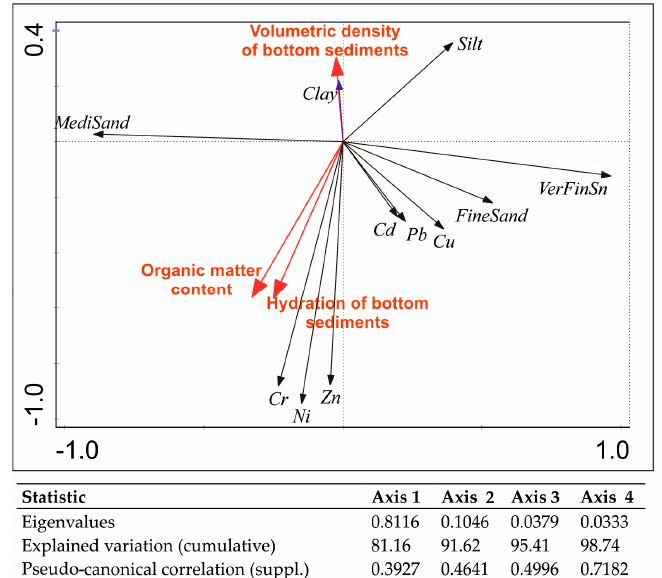
Figure 2. PCA order diagram to determine the influence of environmental factors on the content of trace metals in the bottom sediments of Lake Bukwa ł d. trace metals in the bottom sediments of Lake